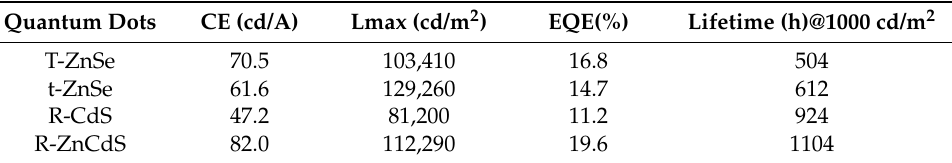
Table 2. Summary of maximum current efficiency (CE, cd/A), luminance (Lmax, cd/m 2 ), EQE (%) and lifetime (h) of QLEDs.